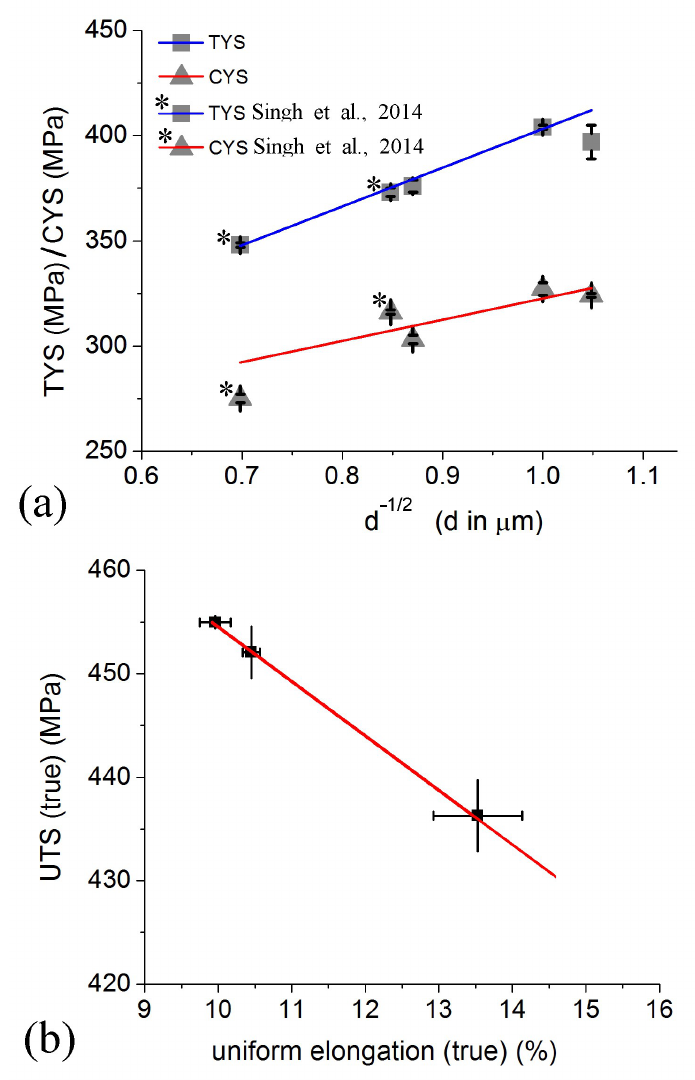
Figure 13. Plots of ( a ) tensile and compression yield stresses (TYS and CYS, respectively) against d − 1 2 , where d is average grain size in µ m (i.e., the Hall-Petch plots) and ( b ) ultimate tensile strengths (UTS) against uniform elongation (from true stress-true strain data). Two data points in ( a ), marked by asterix, are taken from [19] for a chill cast alloy of same composition Mg-3.0Zn-0.5Y in at%, extruded at 250 and 300 ◦